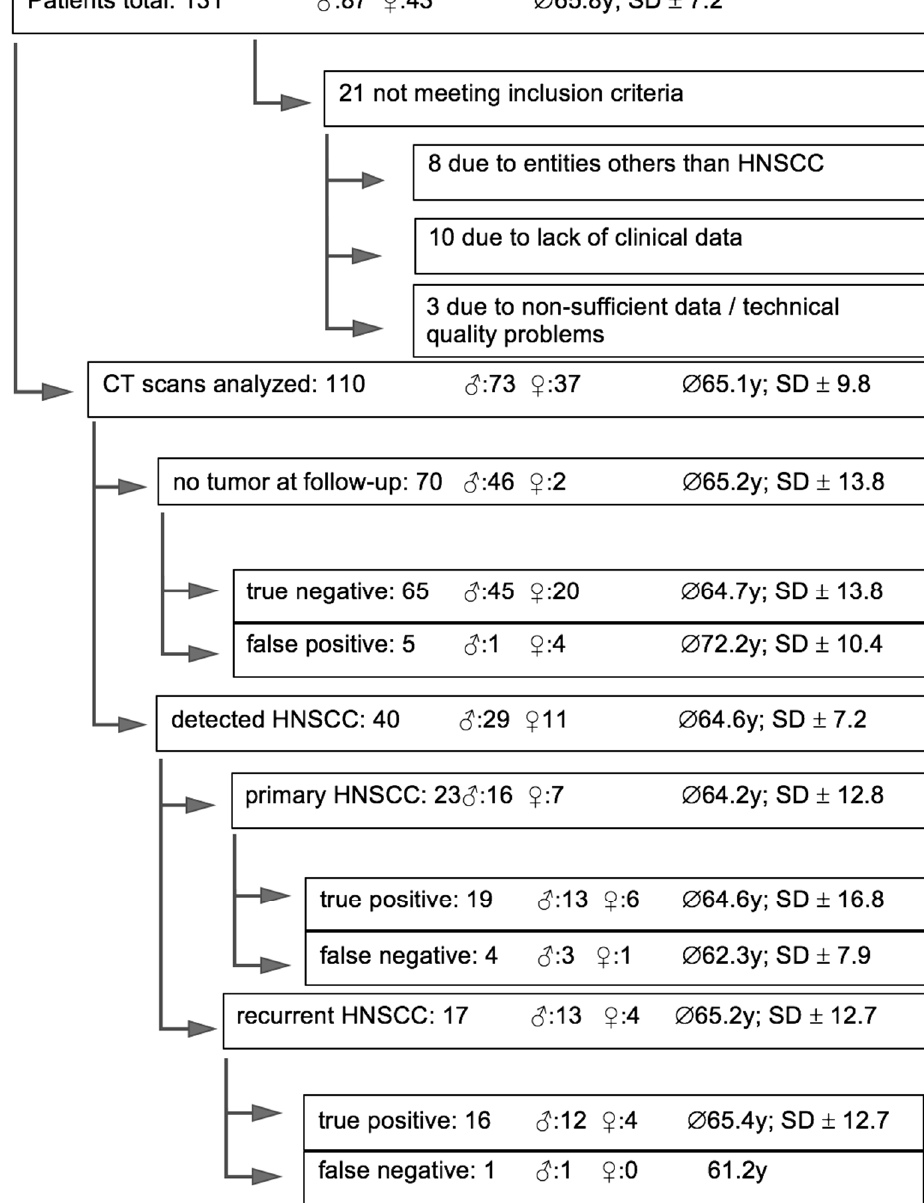
Figure 1. Patient inclusion and exclusion; demographic data; and distribution of Head and Neck Squamous Cell Carcinoma (HNSCC); CT